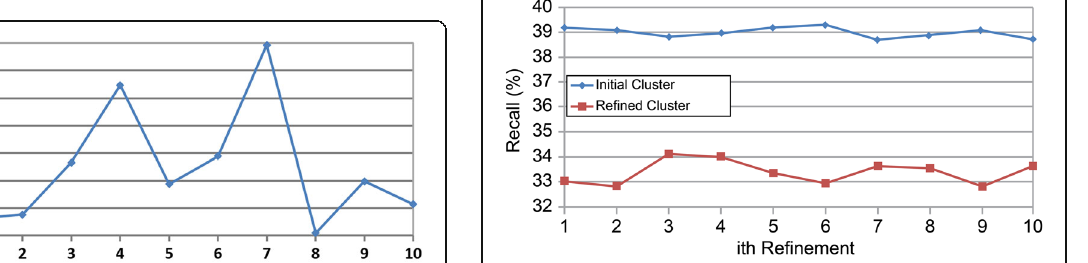
Fig. 5 Recall of the initial cluster and that of the refined cluster after running Tabu Search ten